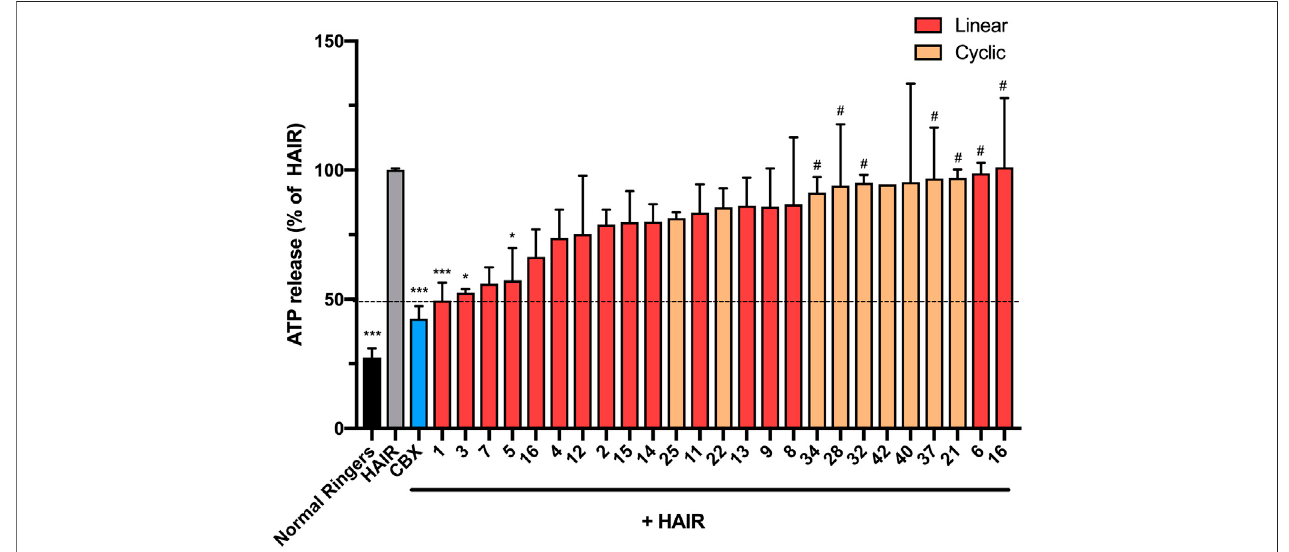
FIGURE 11 | N -terminal, C-terminal, and cyclic modi fi cations affect peptide5 (1) function against ischemic injury – induced ATP release from hCMVEC cells in vitro . N -terminal modi fi ed peptides 3 and 5 displayed ef fi cacy equaling peptide5 (* p < 0.05, *** p < 0.001, respectively). N-terminal modified peptide 6 and the D -arginine – containing peptide 10 equaled the ATP release of the HAIR control indicating a complete lack of activity ( # p < 0.05). None of the cyclic peptides led to a reduction in ATP release that was signi fi cantly different from HAIR control, and a number of peptides ( 34 , 28 , 32 , and 37 ) demonstrated a level of ATP release signi fi cantlygreaterthanpeptide5, indicating lossoffunctionofthesepeptides, # p < 0.05.Allvaluesrepresentthemean,SEM.One-wayANOVA, Dunnett ’ scomparison test against HAIR (*) or peptide5